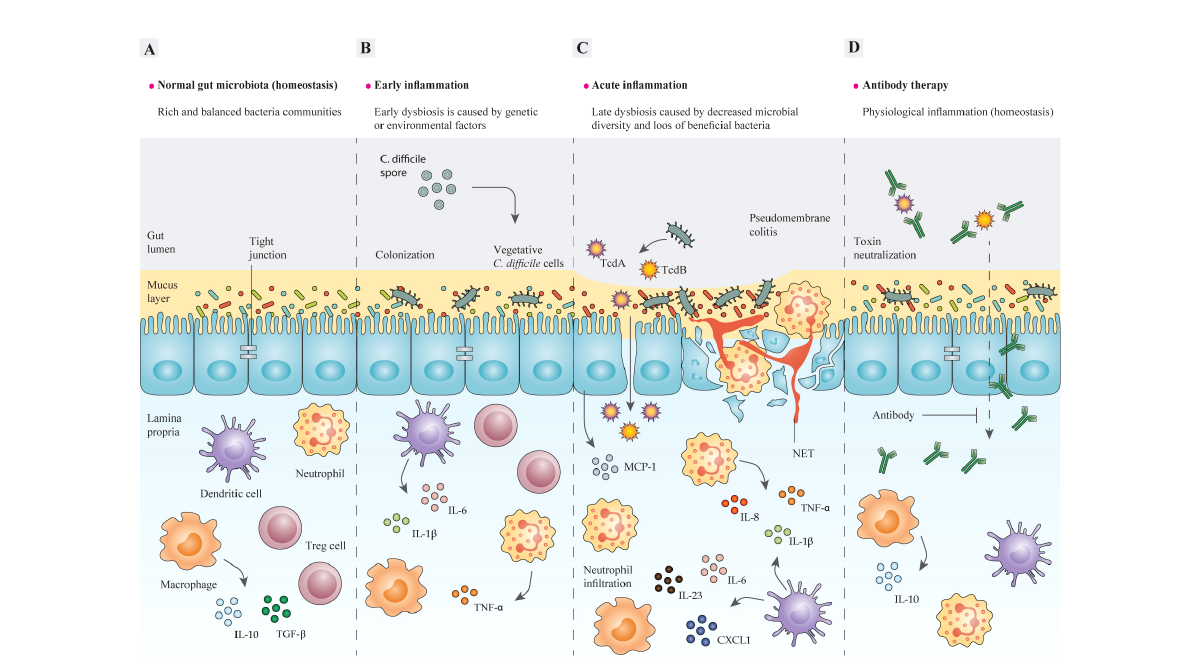
FIGURE 1 The structure of the intestinal epithelium in different stages of C. dif fi cile -induced in fl ammation. (A) In the steady-state, intestinal bacteria are segregated from epithelial cells (IECs) by an intact mucosal layer. A well-balanced relationship is maintained between intestinal microbiota and mucosal barriers during gut homeostasis, so that gut microbes and host immune cells can mutually communicate to regulate the functions of intestinal epithelium. Commensal bacteria and pathogens can modulate the intestinal immune response to release various chemokines and cytokines, or inhibit their production, such as IL-8 and MCP-1. In a homeostasis state, pathogen recognition leads to inducing antigen- presenting cells (APCs), like macrophages, dendritic cells (DC), and neutrophils, which produce pro-in fl ammatory cytokines like IL-1 b and IL-23. In contrast, commensals can stimulate APCs to promote anti-in fl ammatory cytokines, like IL-10 and Treg responses, which suppress the immune response by inhibiting cytokine production, therefore homeostasis and self-tolerance are maintained. In some cases, the interactions between commensal bacteria and the gut epithelium may lead to the discharge of TGF- b from macrophages, which triggers fi broblast proliferation (tissue remodeling). (B) The imbalance between mucosal barriers and gut microbes is promoted by the dysfunction of mucosal barriers, including decreased production of mucin that causes intestinal in fl ammation. A combination of genetic and environmental factors especially antibiotic administration, leads to gut microbiota dysbiosis, and thereby enrichment of pathobionts and susceptibility to C. dif fi cile may occur. The adherence of C. dif fi cile to the epithelium activates host in fl ammatory response via different signaling pathways, which result in production of in fl ammatory cytokines. (C) Epithelium colonization and toxin production by C . dif fi cile act on colonic epithelial and immune cells as in fl ammatory stimuli and induce tissue damage. In particular, the cytopathic effects of TcdA and TcdB lead to disruption of the tight junctions, which causes toxins to cross the epithelial barriers and further induce in fl ammatory cytokine production in lymphocytes, macrophages, and DCs. This further contributes to in fl ammation and neutrophil in fl ux, which subsequently results in a pseudomembrane formation, which is characteristic of C . dif fi cile colitis. (D) The application of monoclonal antibodies (mAbs) developed for targeting toxins of C. dif fi cile helps modulate direct damage to the colonic epithelium caused by toxins and restores the homeostatic immune responses and ameliorates in fl ammation. IECs, intestinal epithelial cells; IL-8, interleukin 8; MCP-1, monocyte chemoattractant protein-1; APCs, antigen- presenting cells; IL-1 b , interleukin 1 beta; IL-23, interleukin 23; Treg, regulatory T cells; IL-10, interleukin 10; TGF- b , transforming growth factor- b ; TNF- a , tumor necrosis factor alpha. IL-6, interleukin 6; DC, dendritic cell; TcdA, Toxin A; TcdB, Toxin B; mAbs, monoclonal